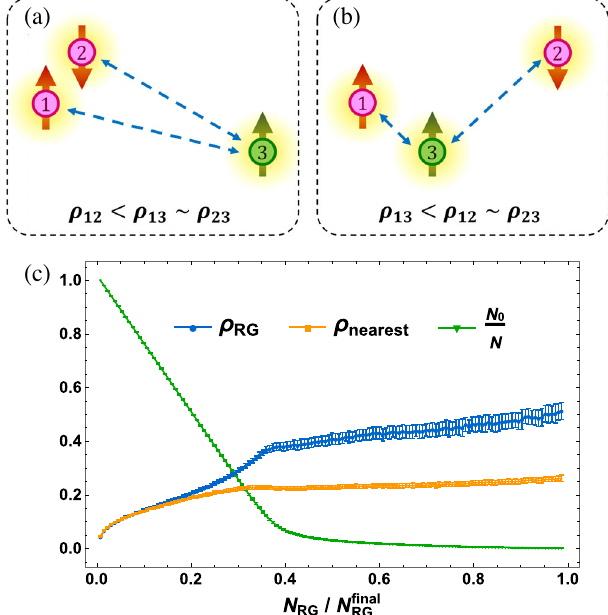
FIG. 6. Microscopic analysis of the renormalization of the antisymmetric modes. (a) Pictorial representation of the near-field interaction between the antisymmetric mode of a pair (repre- sented by two out-of-phase dipoles, pink circles labeled 1 and 2) and a third atom (green circle, with label 3), which may sit very far from the pair (characterized by the distances ρ 12 < ρ 13 ∼ ρ 23 ). In this case, the interaction strength scales like 1 = ρ 4 13 , reflecting the higher-order multipole nature of the out-of-phase dipoles. (b) Similar illustration for the case where the third atom sits closer to one atom of the pair (say, atom 1) than the pair separation itself ( ρ 13 < ρ 12 ∼ ρ 23 ). The interaction strength then scales like 1 = ρ 3 13 . (c) System properties during the RG flow. The horizontal axis quantifies how many pairs N have been renormalized, from the RG 0 ) towards the end ( N N final beginning ( N ) of the RG ¼ RG ¼ RG algorithm. As one atom can be renormalized more than once, > N= 2 . The blue circles represent the average typically N final RG interatomic distance ρ of those pairs that get renormalized, RG while the orange squares show the average distance ρ nearest between the atoms of those pairs and their respective nearest atom, chosen among those that are still allowed to interact (i.e., 1 ). The green triangles display the fraction of atoms with L ij ¼ N 0 =N that have never been renormalized up to that moment of the flow. The data represent the average over around 300 runs over different random atomic positions, uniformly sampled inside a 0 . 55 λ η ≈ 32 . The bars show sphere of radius r 0 and density sph ¼ 1 standard deviation in the accumulated